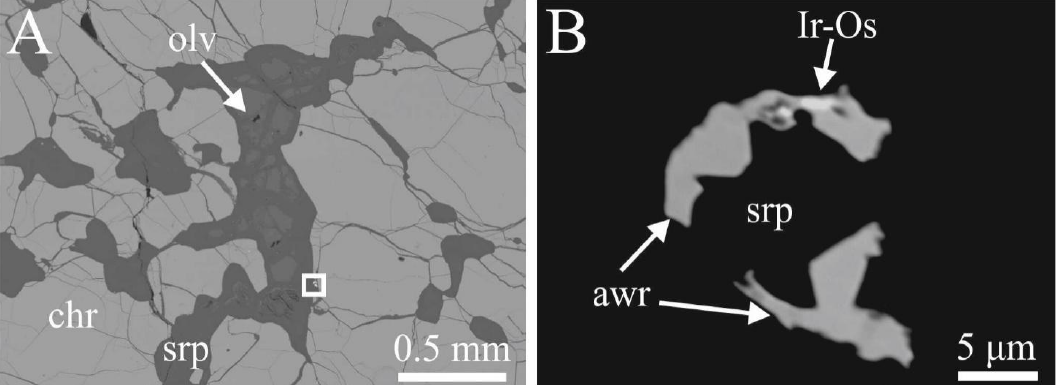
Figure 11. BSE images of secondary Ir-Os alloy from Kabaena Island chromitite ( A ) and enlargement of A ( B ). Abbreviations: chr = chromite, srp = serpentine, olv = olivine, Ir-Os = iridium – osmium alloy, and awr = awaruite.